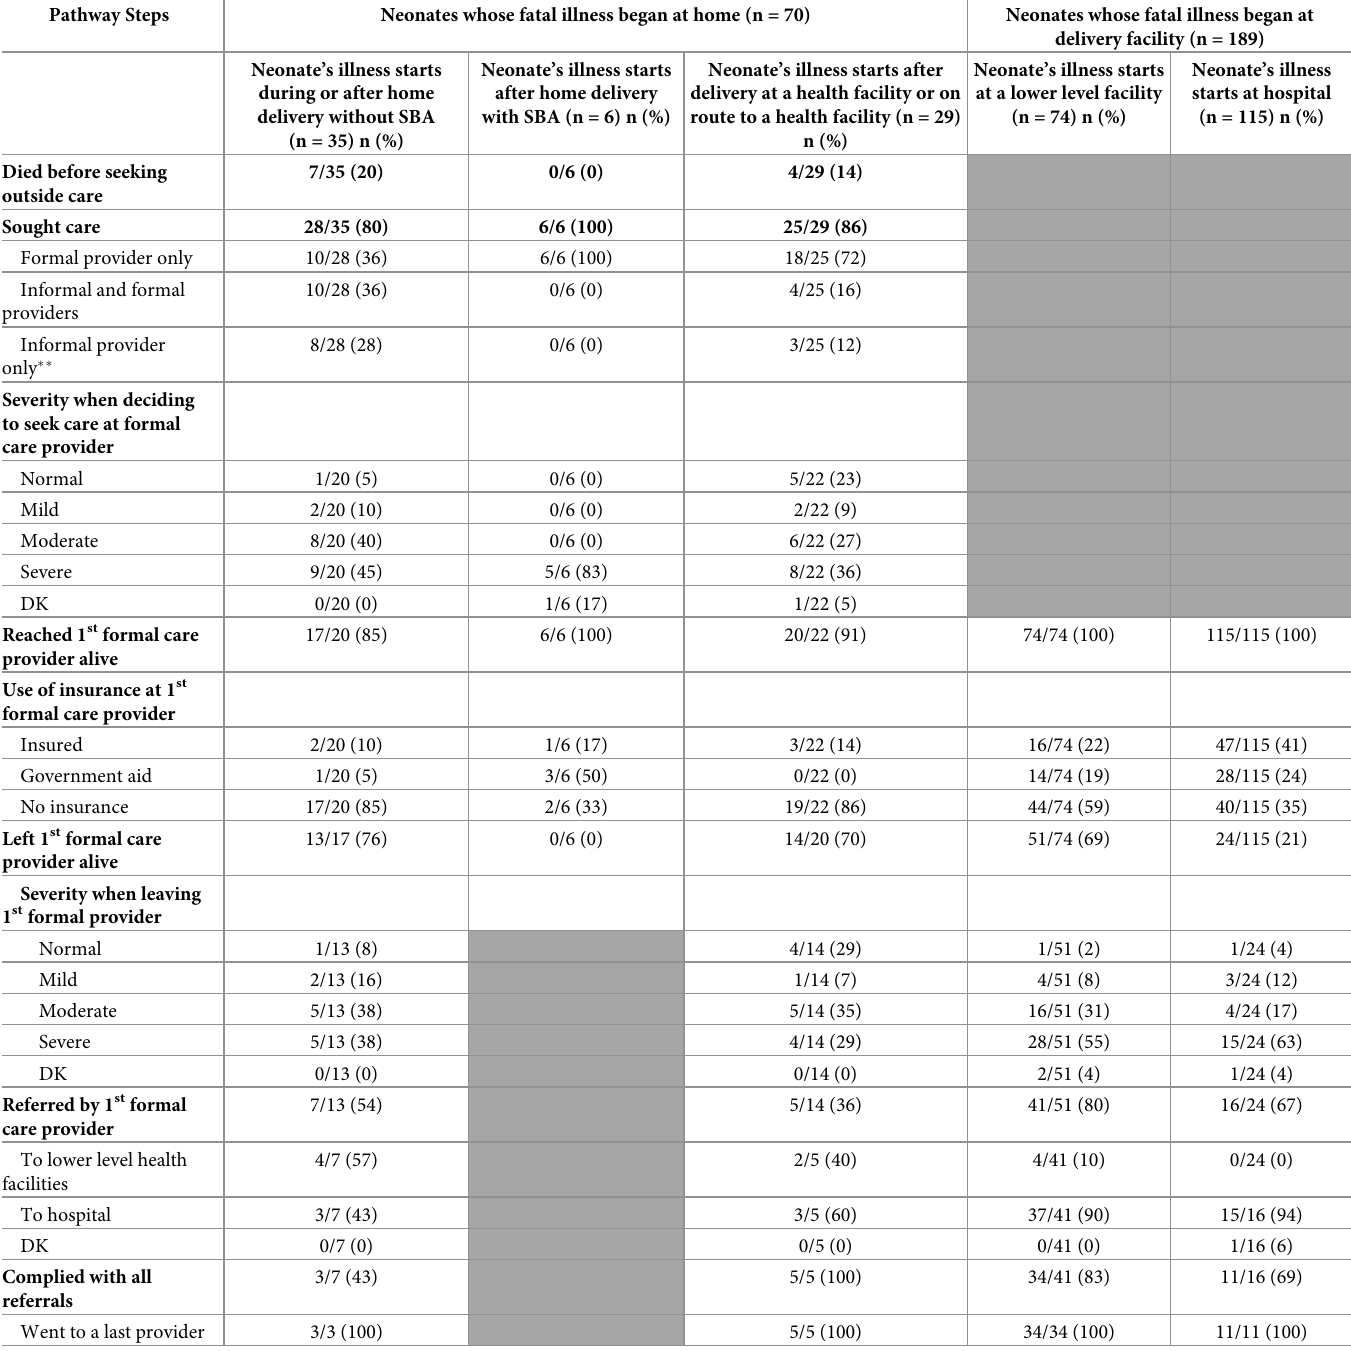
Table 4. Steps in care seeking